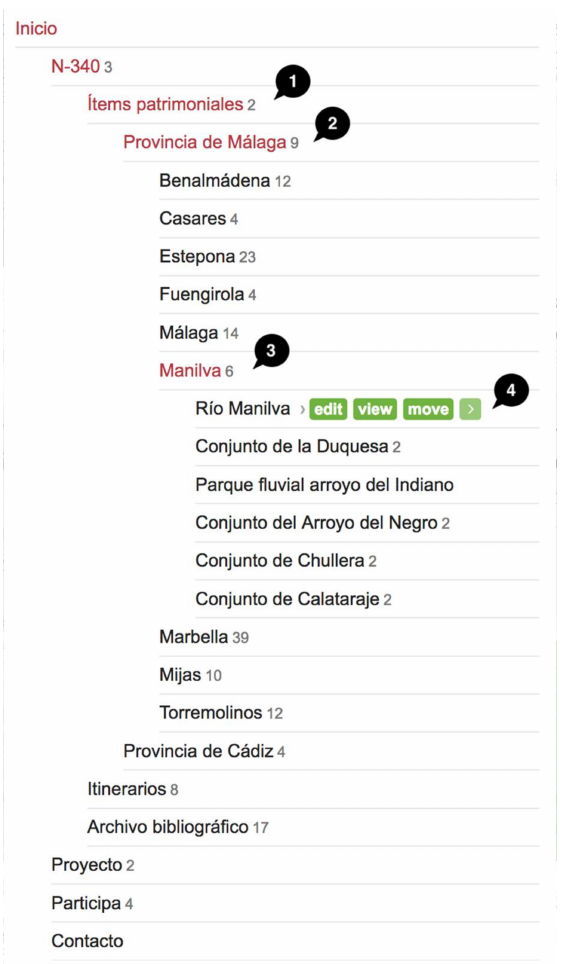
Figure 7. Tree structure. ProcessWire’s tree structure enables intuitive, logical content